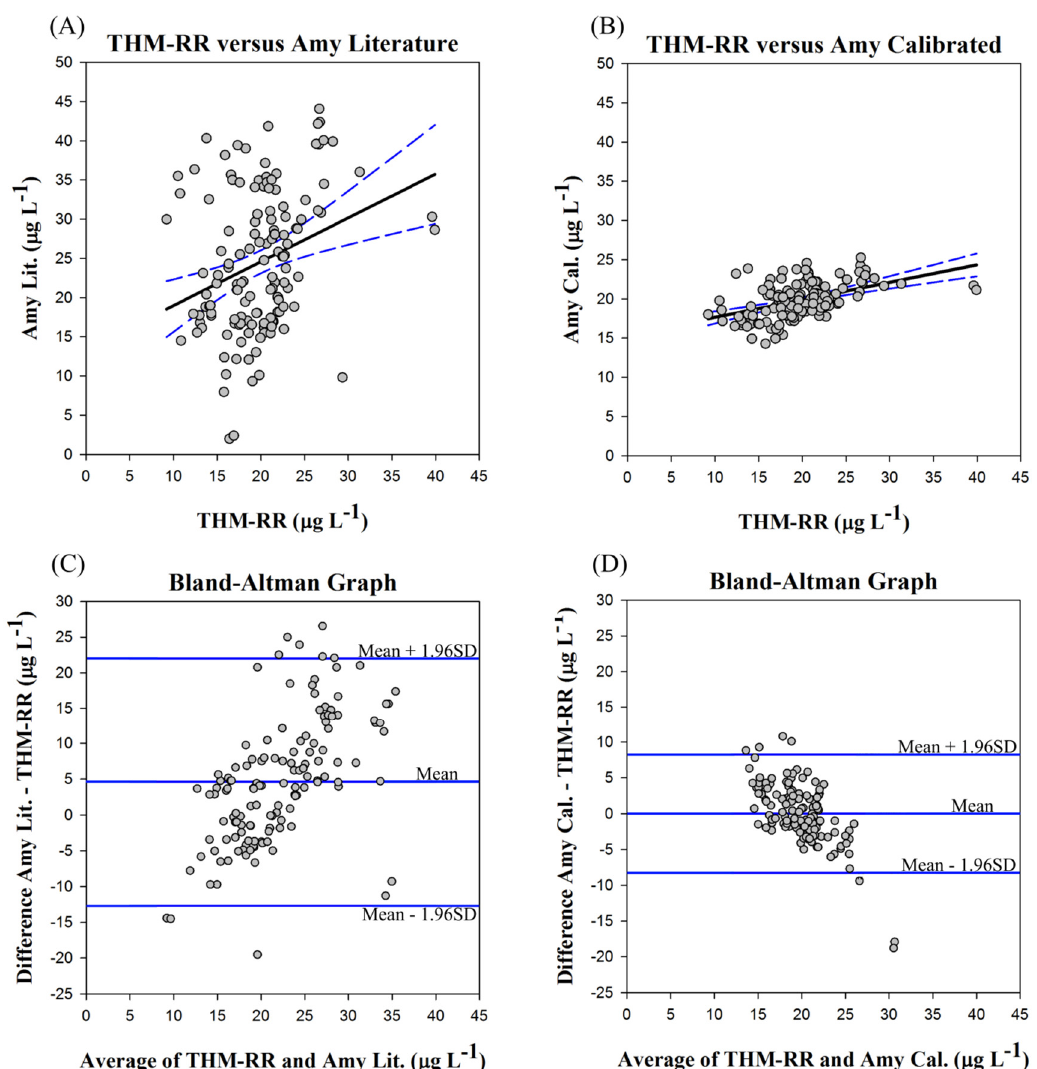
Figure 5. Bland-Altman Plots for the Amy literature and calibrated models for the period of 1 May 2013 through 3 January 2014. ( A ) Amy Literature generated Total THMs concentrations vs. THM-RR measurements; ( B ) Amy Calibrated generated Total THMs concentrations vs. THM-RR measurements; ( C ) Difference plot for the Amy Literature model and THM-RR measurements of Total THMs; ( D ) Difference plot for the Amy Calibrated model and THM-RR measurements of Total